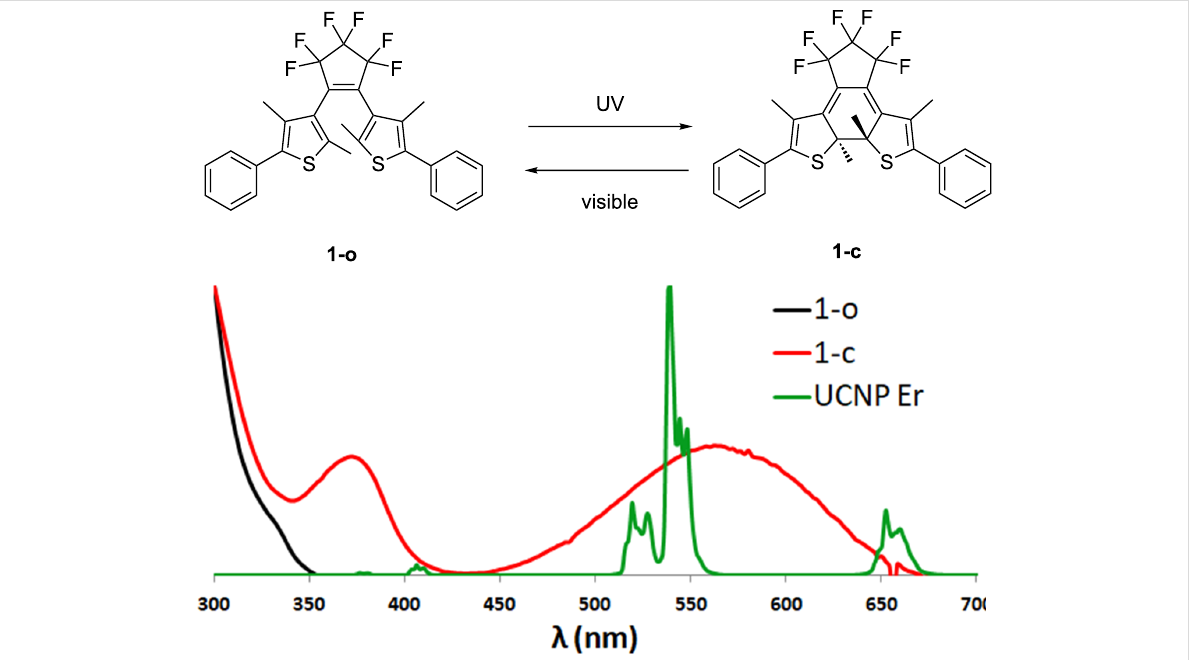
Figure 1: Top: photoisomers of diarylethene 1 , bottom: spectral overlaps between the 1-o (black line), 1-c (red line) UV–vis absorption spectra and the Er-UCNP emission spectrum (green line).